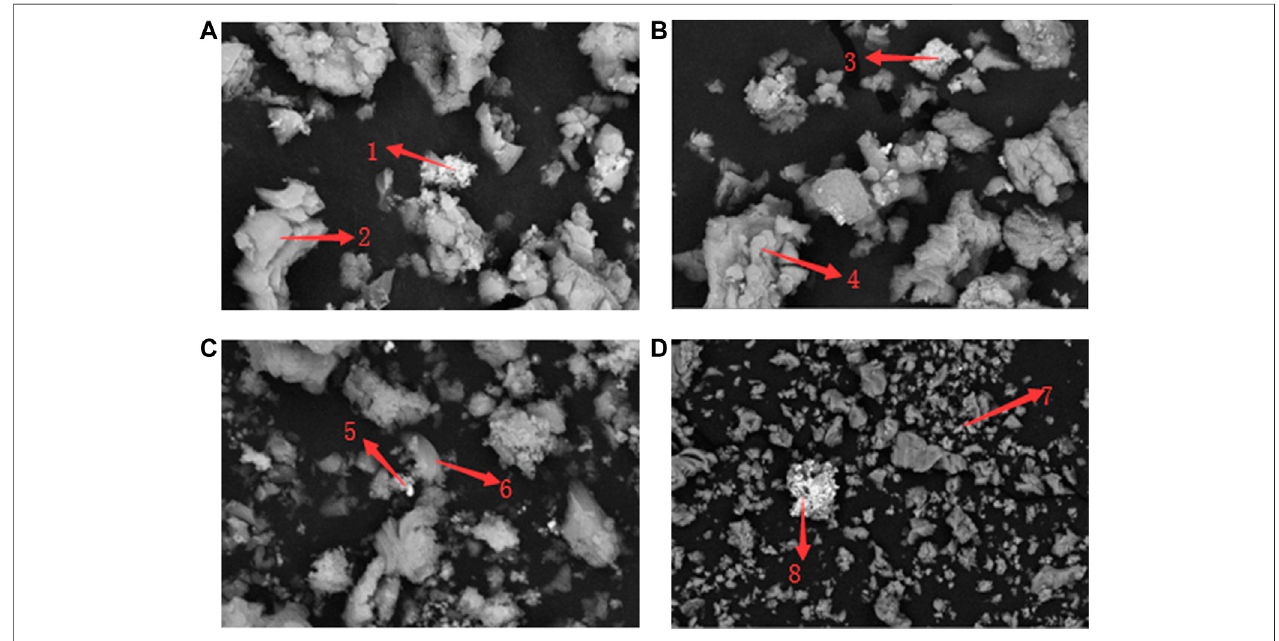
FIGURE 7 | SEM spectra of Mg-modi fi ed catalysts with different doping mass proportions: (A) 3%, (B) 6%, (C) 9%, and (D) 12%.